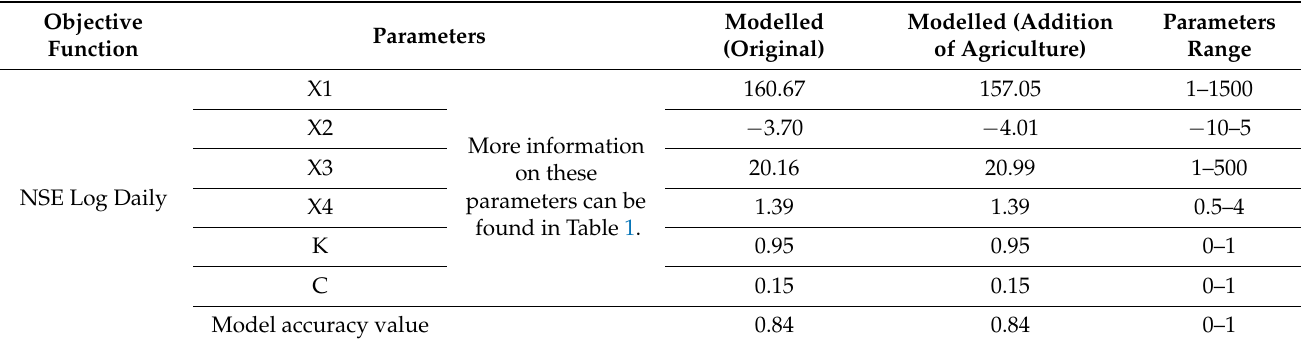
Table 9. The parameters of the rainfall–runoff models before and after land-use